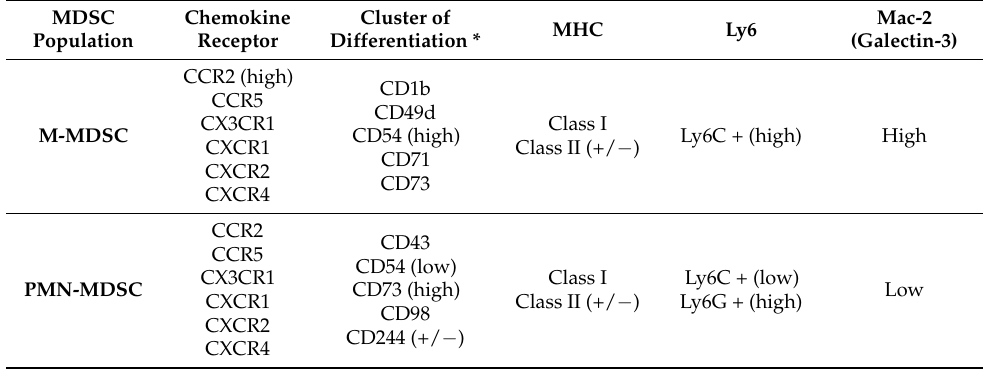
Table 1. Differential expression markers in the populations of MDSCs in animal models.